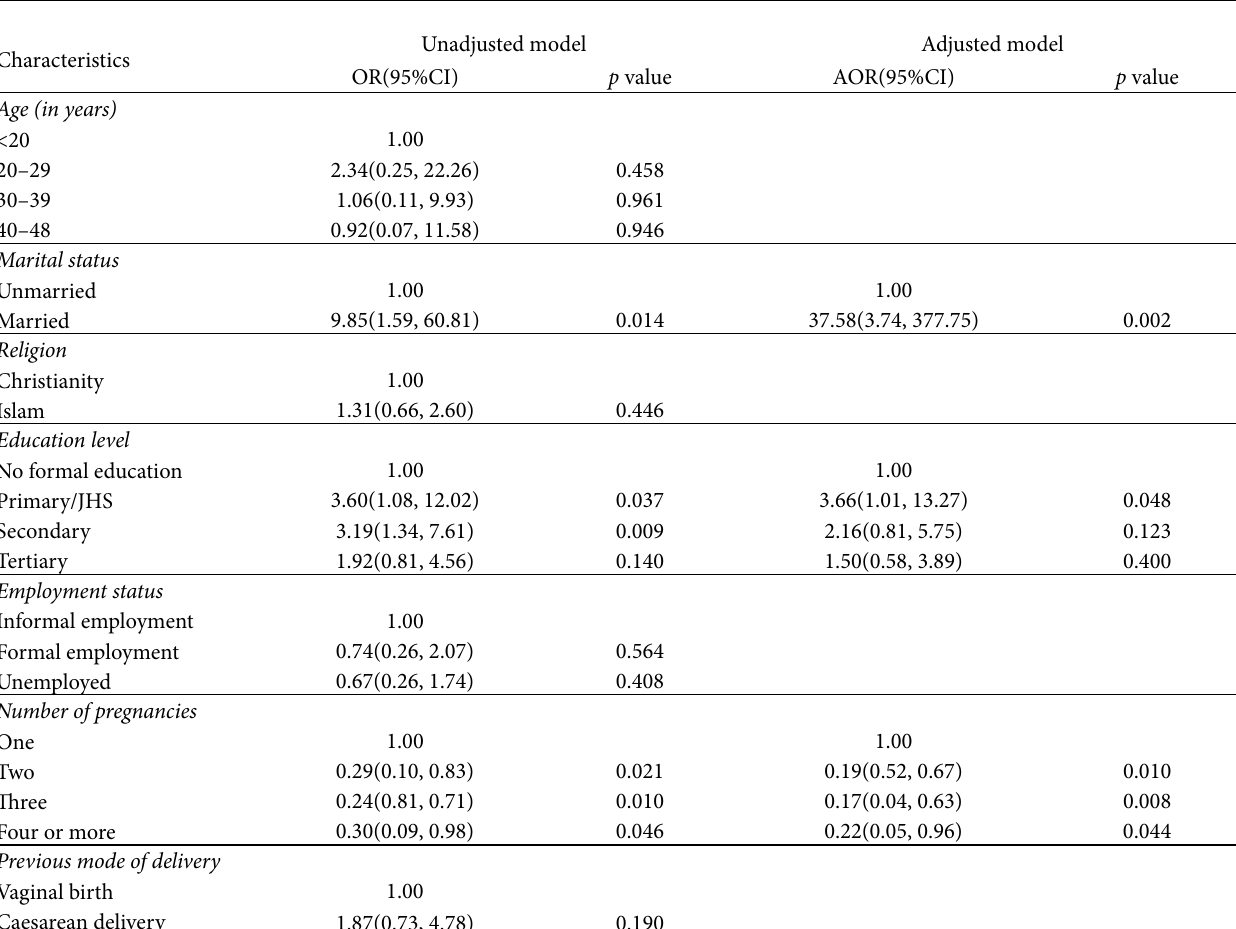
Table 5: Socio‐demographic determinants of women's perspective about male partner involvement in